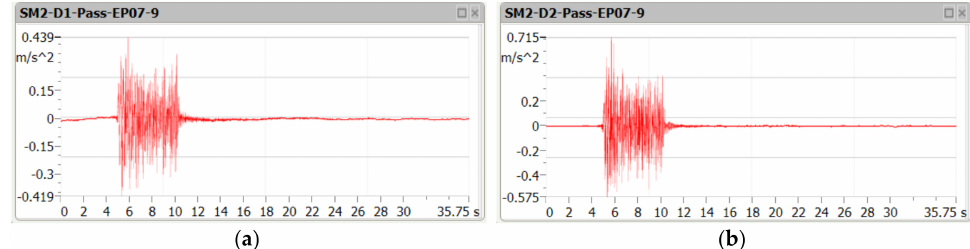
Figure 7. Amplitude of vertical vibration acceleration during the passage of the passenger train at the speed of 110 km/h, in the deck slab ( a ) and the bottom flange of the girder ( b